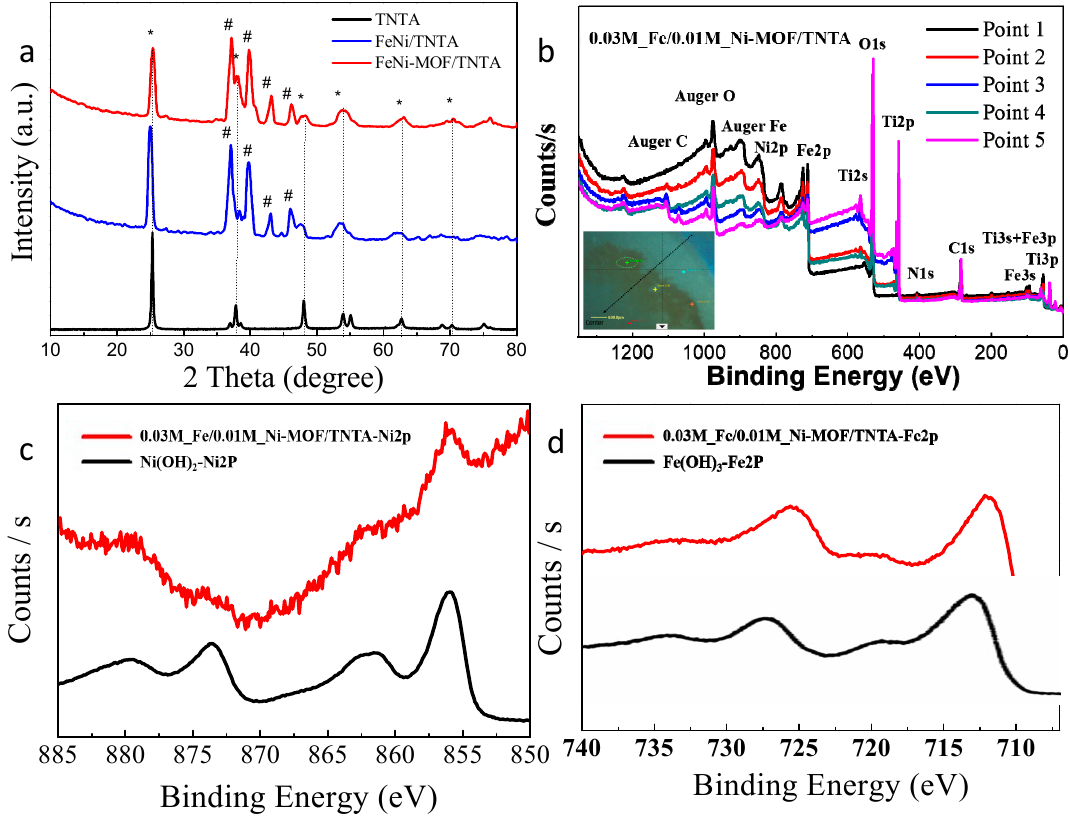
Figure 3. Elemental analysis of the TNTA, FeNi/TNTA, and FeNi-MOF/TNTA (0.03M_Fe/0.01M_Ni) ( a ) XRD patterng (*: anatase; #:Fe/Ni), ( b ) X-ray photoelectron spectroscopy (XPS) survey spectra, XPS spectra of ( c ) Ni 2p, and ( d ) Fe 2p of FeNi-MOF/TNTA.